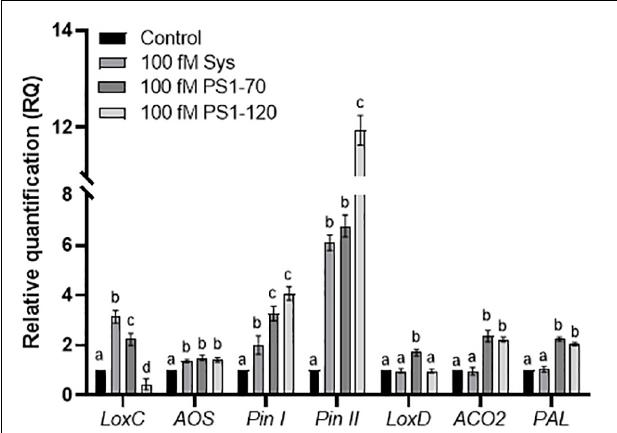
FIGURE 6 | Expression analysis of defense related genes by RT-PCR. Relative quantification of early and late defense genes induced at 6 h post treatment with 100 fM of Sys, PS1-70 and PS1-120. Quantities are shown relative to the calibrator control condition, set as 1 (mock-treated plants). Letters indicate different statistical groups (One-Way ANOVA, P < 0.05). Error bars indicate standard